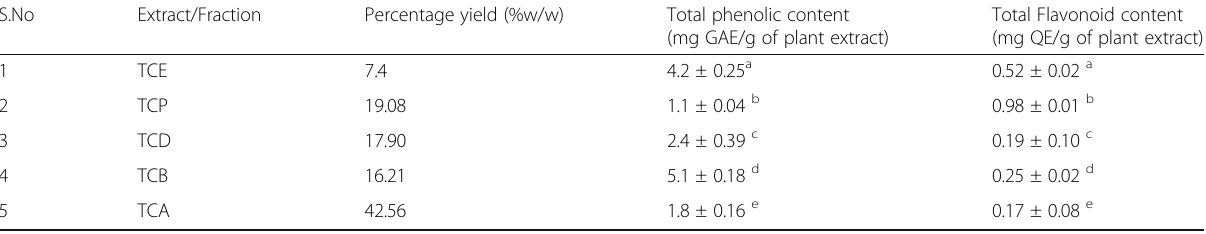
All the values are expressed as mean ± SEM ( n = 3) a-e Column wise values with different superscripts of this type indicate significant difference ( P <